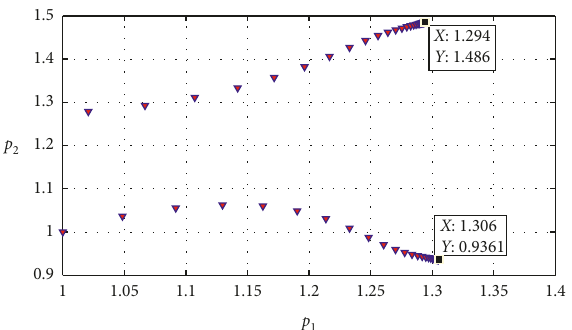
Figure 7: Time series graph of game prices with g